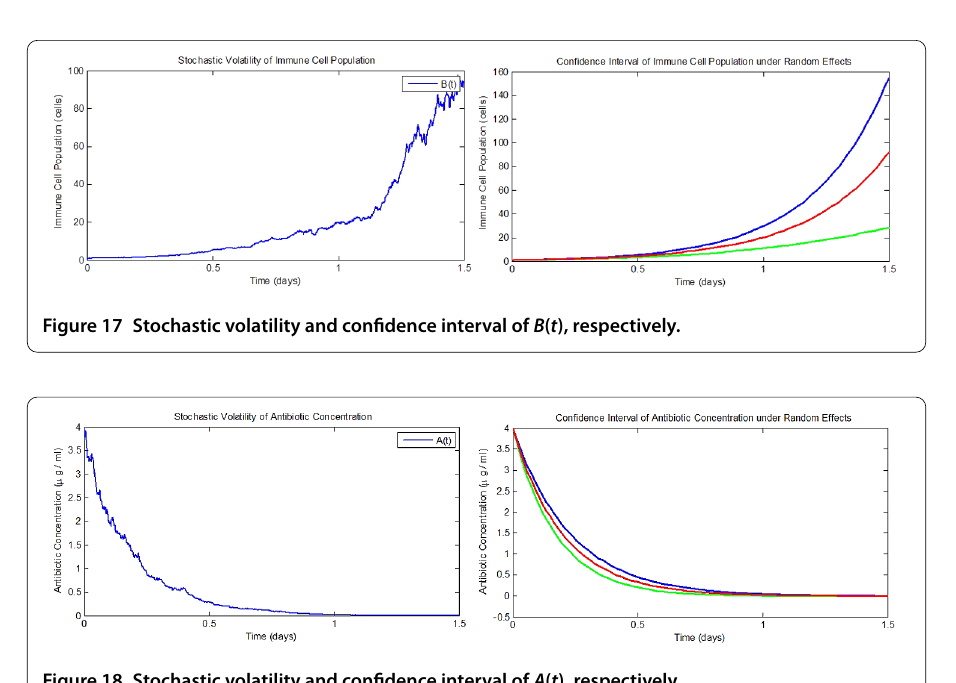
Figure 18 Stochastic volatility and confidence interval of A ( t ),